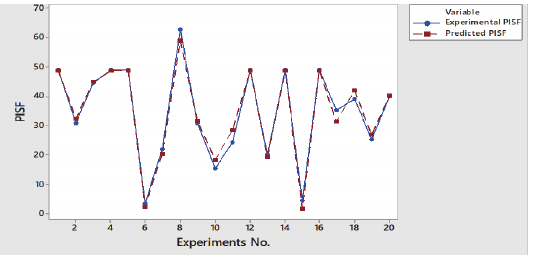
Fig. 5. Optimization of PISF by using desirability approach Fig. 6. Comparison between predicted PISF and experi-